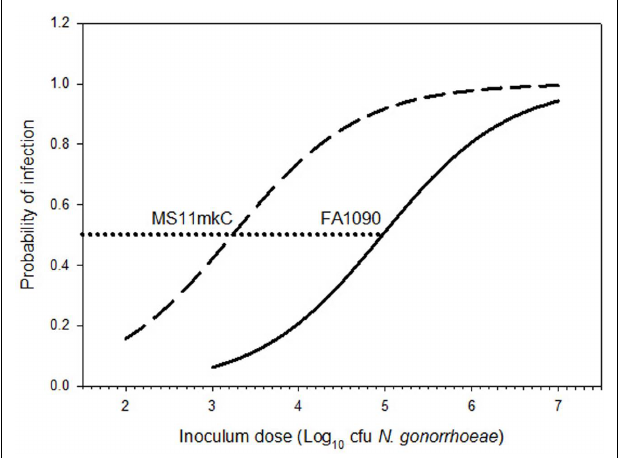
FIGURE 1 | Neisseria gonorrhoeae strain MS11mkC is more infectious than strain FA1090 in experimental infection of the male urethra. Multiple logistic regression analysis was used to generate dose response models with data from 55 men inoculated with MS11mkC (dashed line) and 43 men inoculated with FA1090 (solid line). All inocula contained predominantly piliated, Opa-negative, wild-type gonococci.The estimated ID 50 (indicated by the horizontal dotted line) is 1.8 × 10 3 cfu for MS11mkC and 1.0 × 10 5 cfu for FA1090.